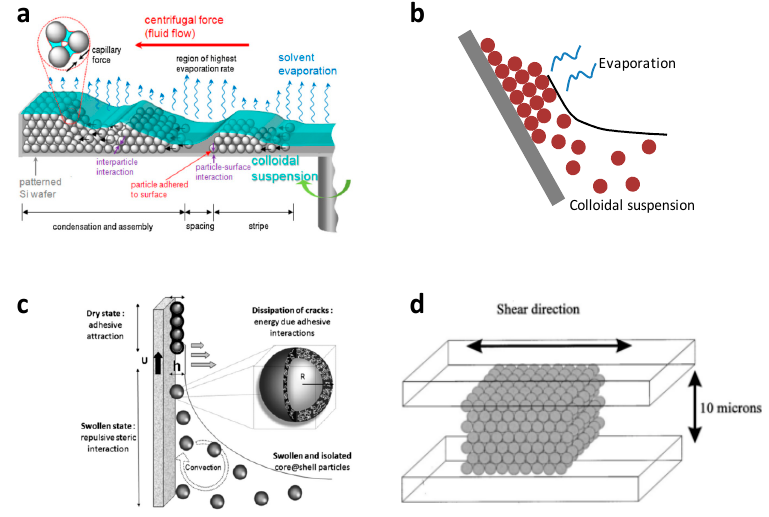
Figure 3. Schematics of colloidal assembly by: ( a ) spin-coating [30]; ( b ) vertical deposition; ( c ) dip coating [38]; and ( d ) shear alignment [39].